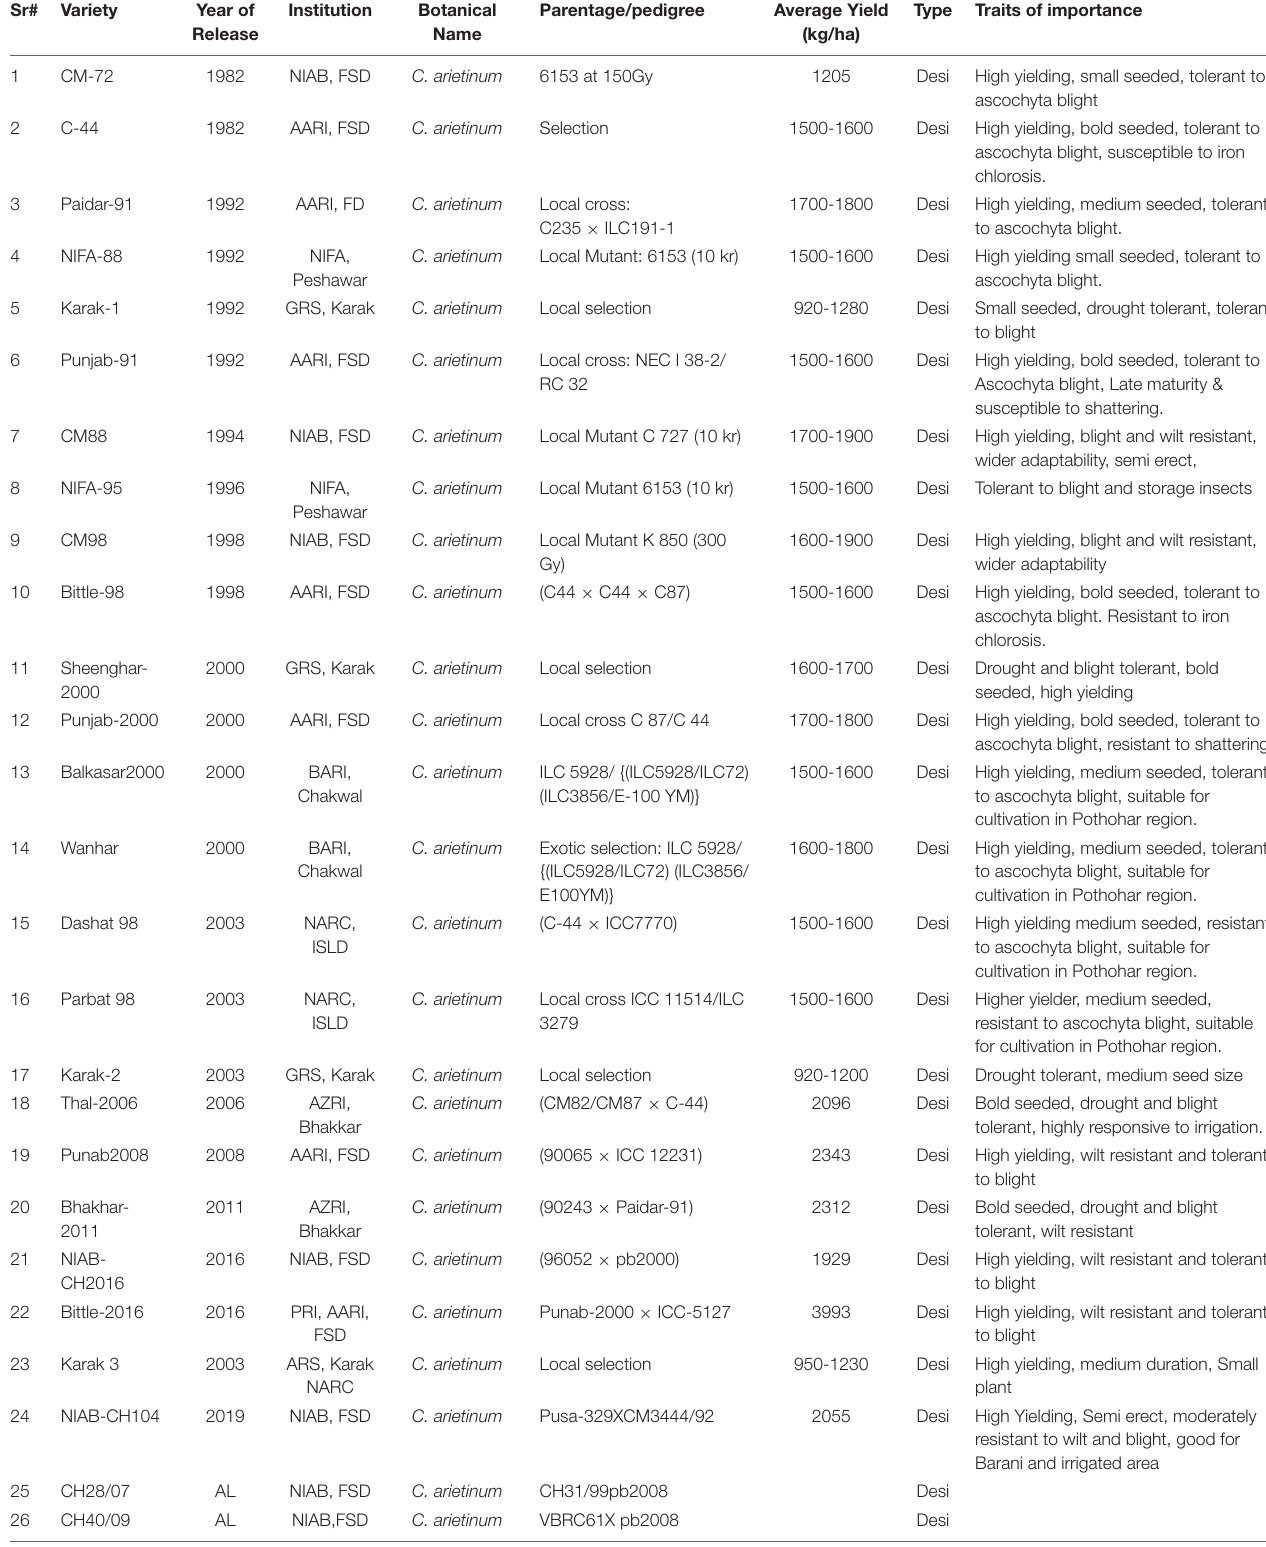
TABLE 1 | Chickpea genotypes along with known traits, used in the study. Sr#